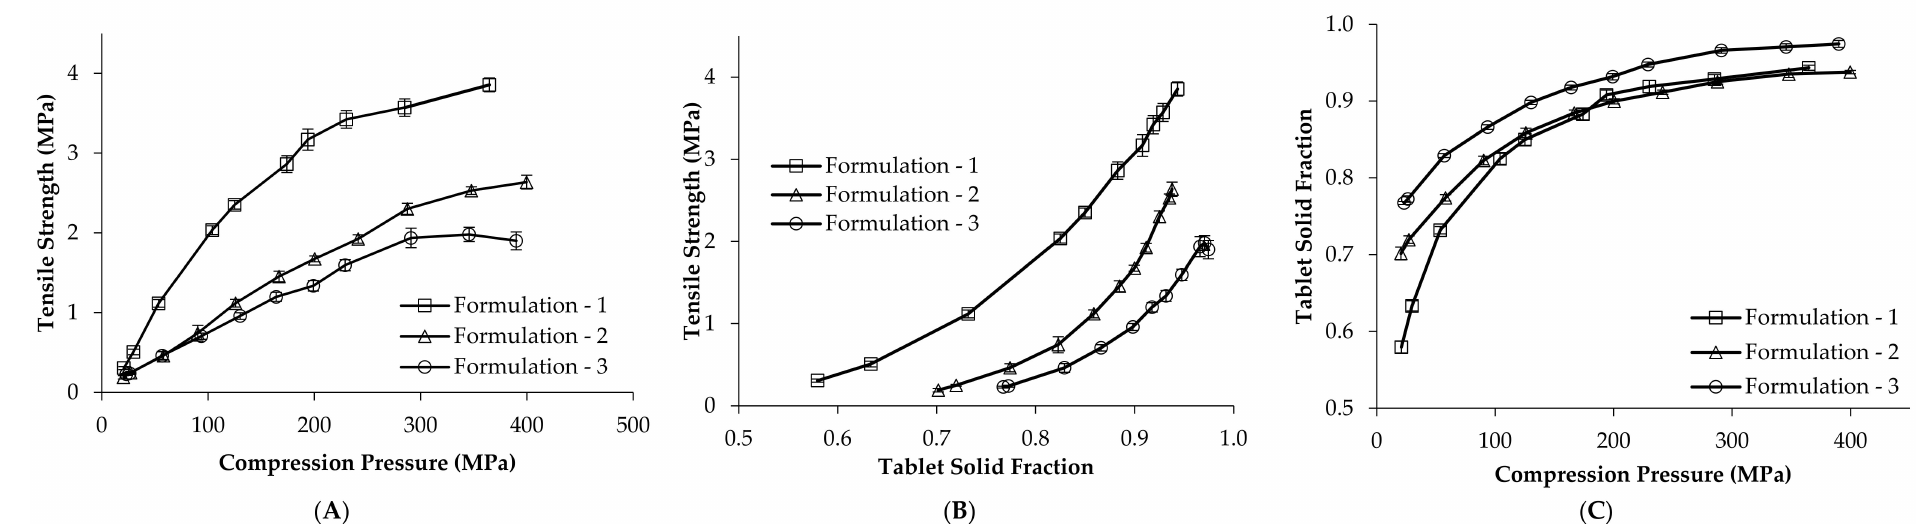
Figure 1. ( A ) Tabletability profile, ( B ) compactibility profile and ( C ) compressibility profile of three placebo formulations (formulation 1 (plastic), formulation 2 (elastic) and formulation 3 (brittle) on the KG RoTab tablet press at a press speed of 11,400 TPH. Average values are shown, n = 10, the y error bar indicates standard